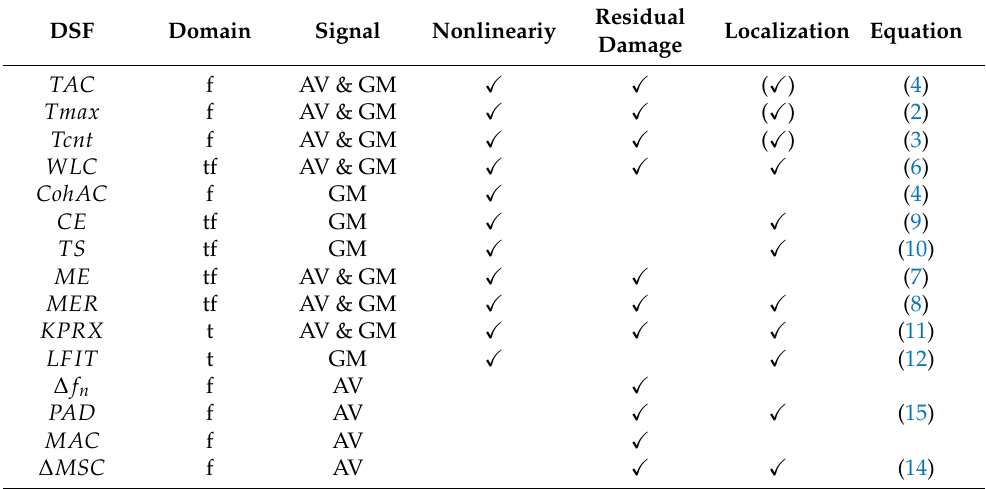
Table 1. Summary of the damage-sensitive features (DSFs) reviewed in Section